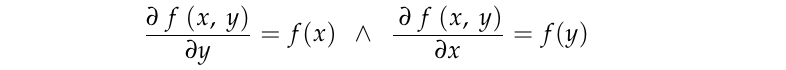
Figure 3. PWC (z = f(x)) and PWL (z = f(y)) approximation, with 𝑘 = 1,… , (𝑛 𝑥 − 1) and 𝑙 = 1,…, (𝑛 𝑦 − 1). The two newly introduced indices 𝑘 and 𝑙 index the areas, whereas 𝑖 and 𝑗 are used to index the breakpoints and function values (Section 2.2.1). By selecting the area 𝑘 or 𝑙 , the upper and lower limits stored in 𝑥, 𝑦 , and 𝑧 can be accessed (Section 2.3.1).